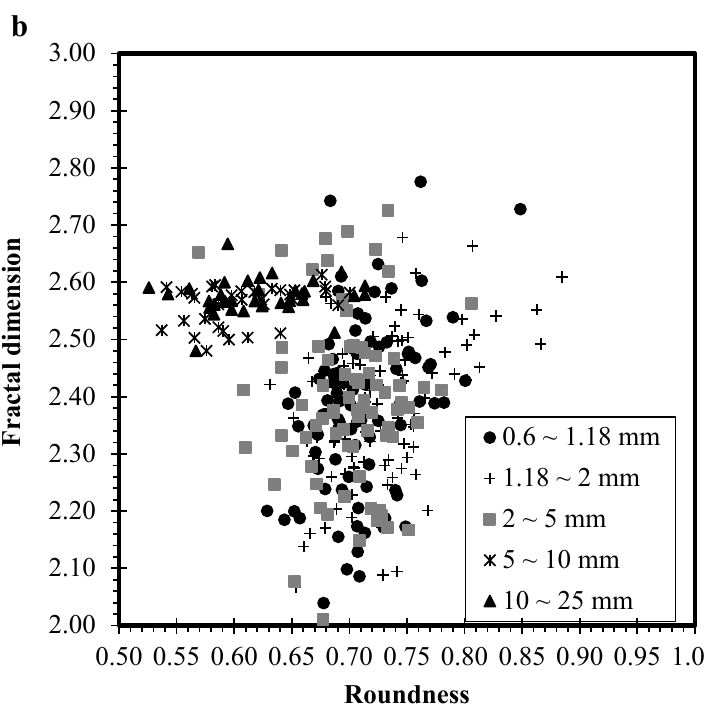
Figure 5. Correlation between shape descriptors: ( a ) roundness and sphericity and ( b ) fractal dimension and roundness.